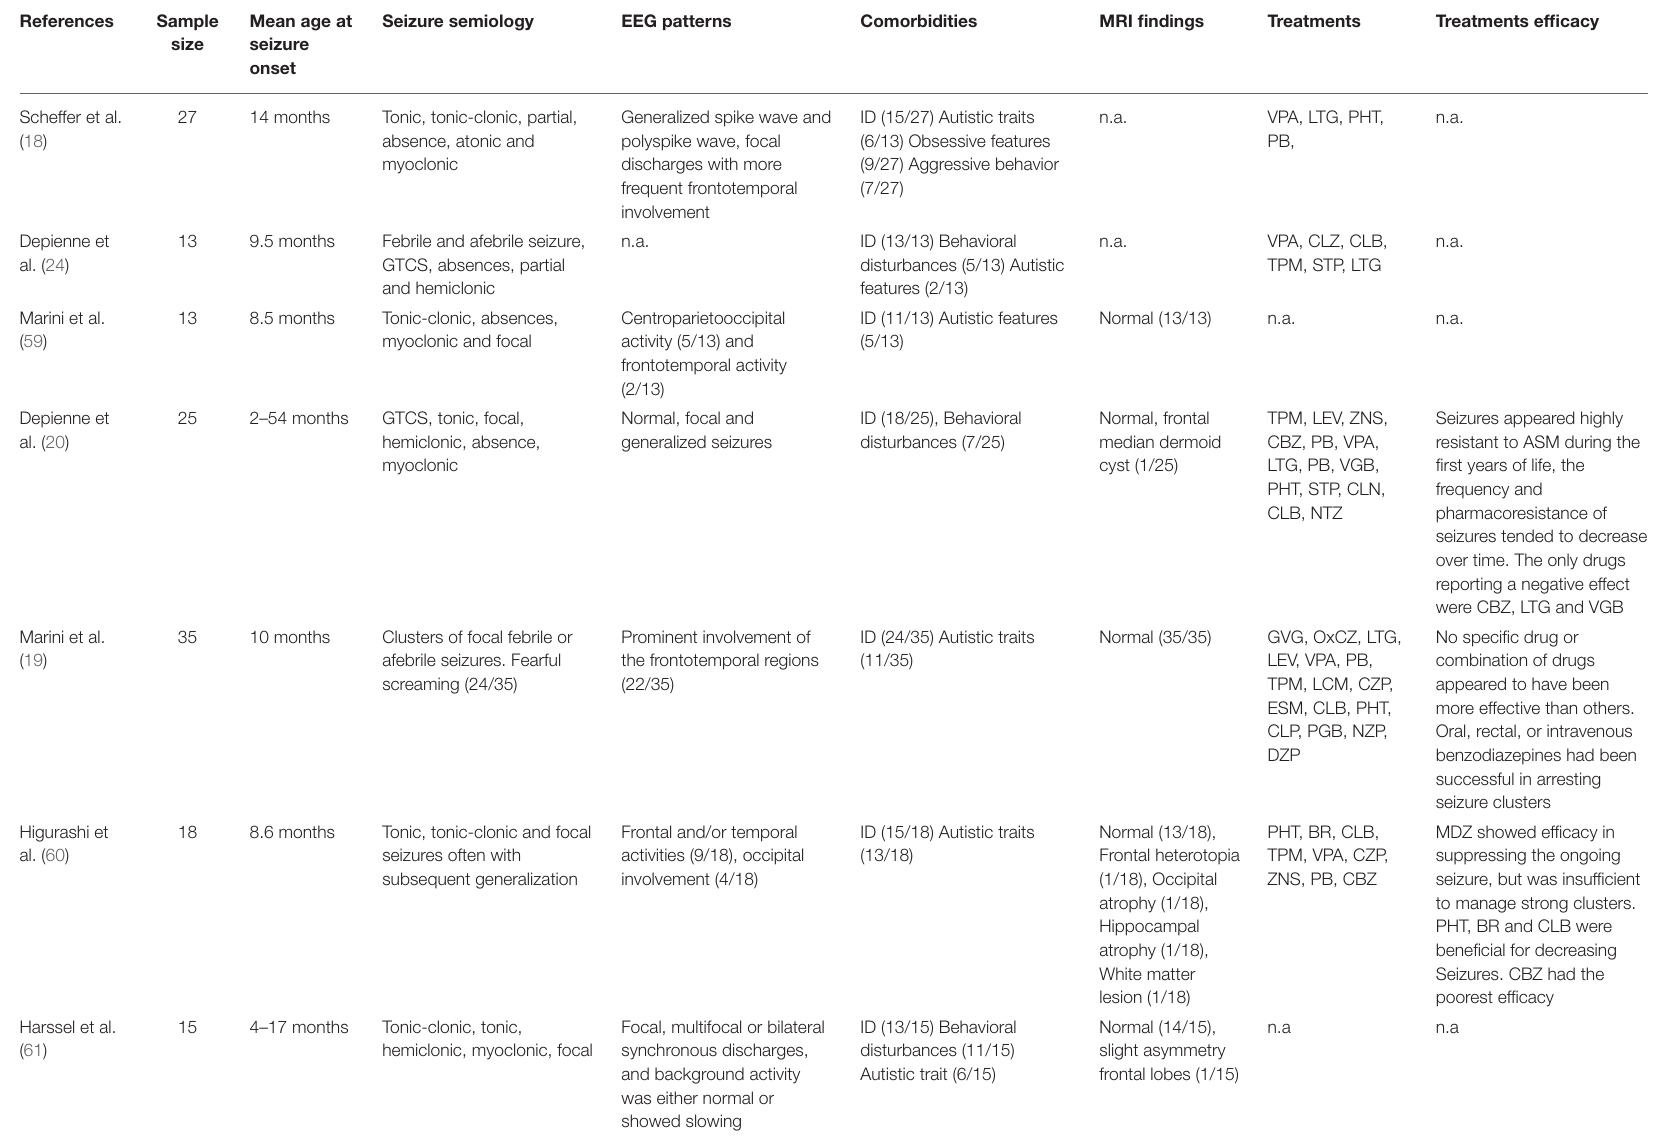
TABLE 1 | Clinical, EEG and MRI characteristics and treatment efficacy in PCDH19-related